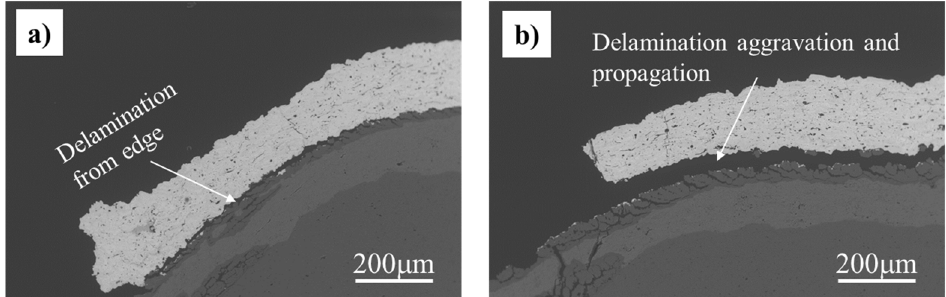
Figure 12. SEM images of APS EBCs coating edges after steam cycling. ( a ) 200 cycles; ( b ) 400 cycles.